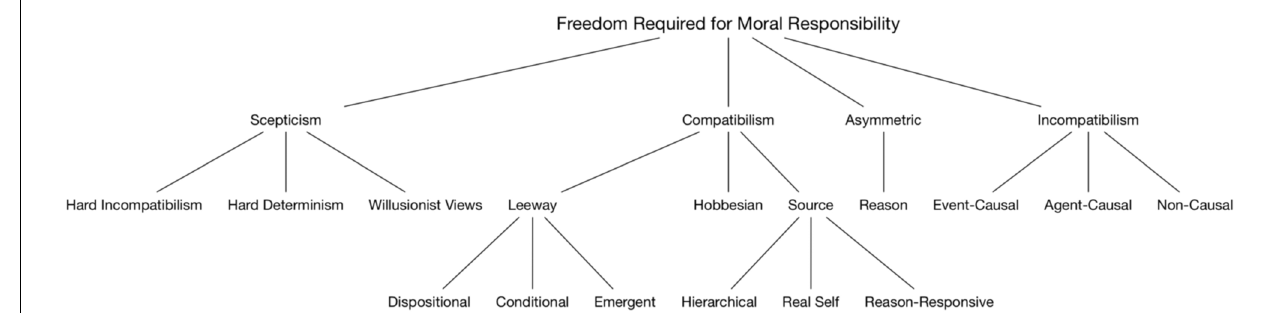
FIGURE 3 | A taxonomy of the different philosophical accounts of free will [adapted from Elzein and Pernu